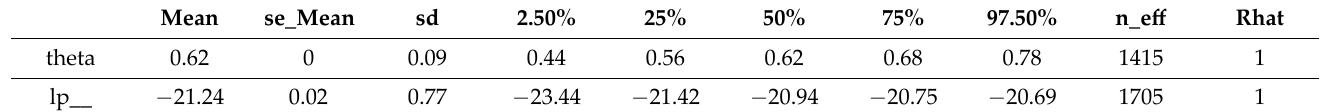
Table 1. RStan [51] output for fitting the probability of a positive rating. The analysis entails 4 chains, each with 2000 iterations, 1000 warmup samples. The total post‑warmup draws are 4000 samples.